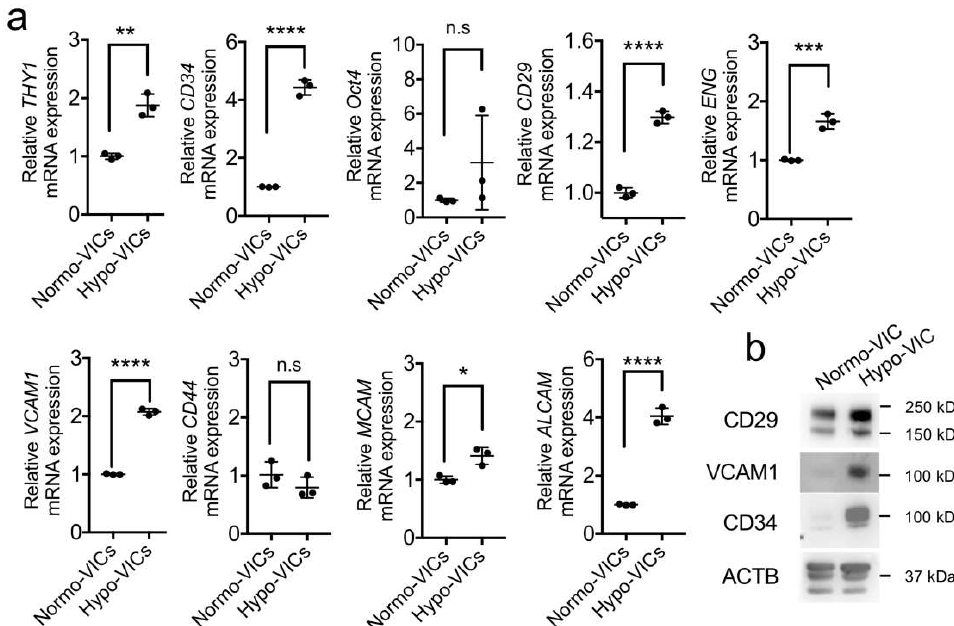
Figure 4. Expression of mesenchymal and hematopoietic stem cell markers in hypo- and normo-VICs. ( a ) Quantifications of mRNA levels for THY1, CD34, Oct4, CD29, ENG, VCAM1, CD44, MCAM , and ALCAM ( n = 3). Expression levels were normalized to those of GAPDH . Data are presented as means ± SE. ( b ). Validation of CD29, VCAM1, and CD34 upregulation in hypo-VICs by western blotting. * p < 0.05, ** p < 0.01, *** p < 0.001, **** p < 0.0001. n.s.: Not significant.